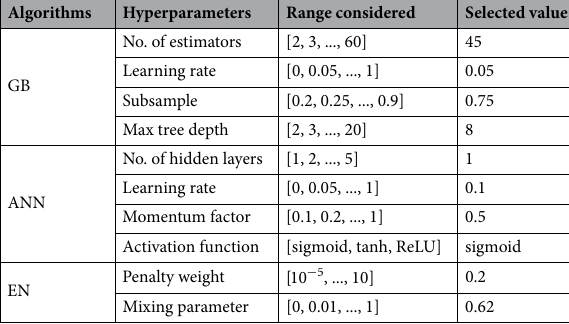
Table 5. Tuned hyperparameters of competitive methods.